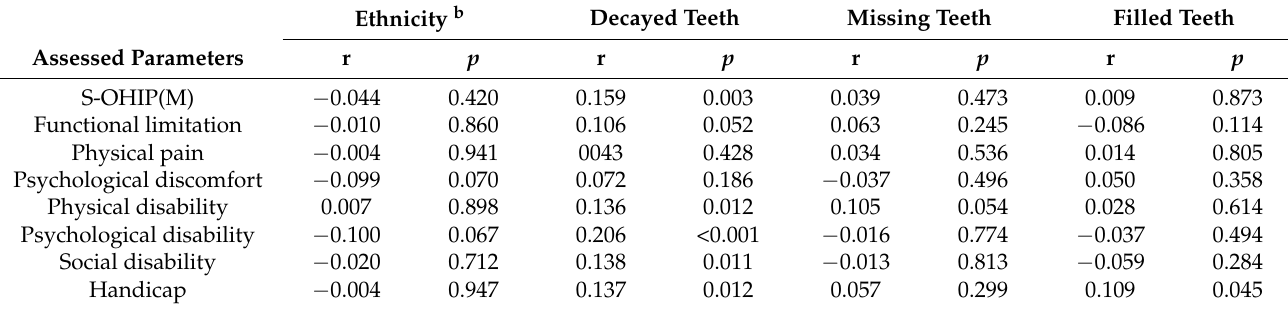
Table 5. Partial correlation analyses of S-OHIP(M) total and domain scores for Malay or Chinese ethnicity; decayed, missing, or filled teeth ( n = 340) a . Ethnicity b Decayed Teeth Missing Teeth Filled